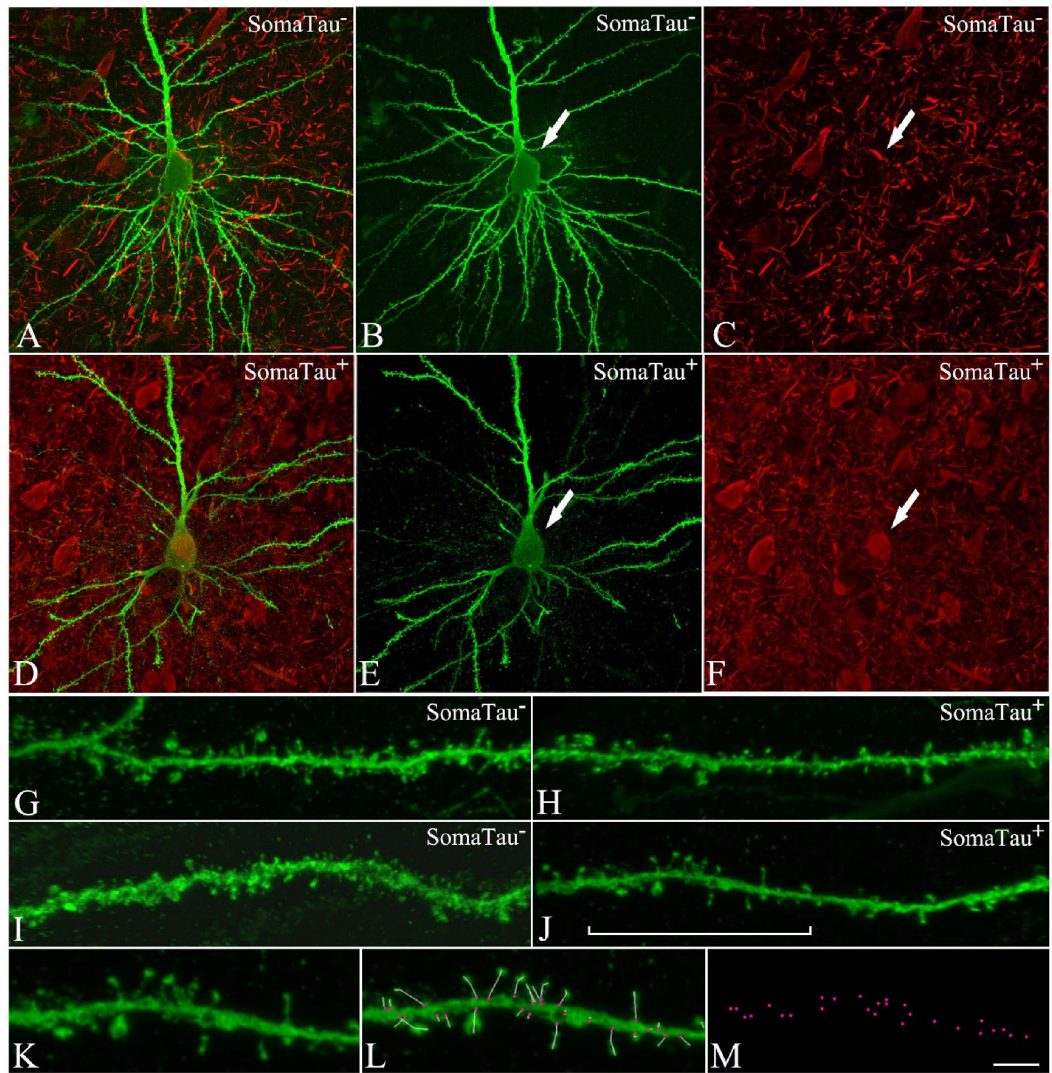
Figure 1. CA1 pyramidal neurons with and without tau pathology. Confocal microscopy pictures obtained after combining the channels acquired separately for LY (green) and phospho-tau AT8 (red), showing ( A–F ) neurons and ( G–J ) their basal dendrites, ( A–C,G–H ) with a soma free of phospho-tau AT8 (SomaTau-) and ( D–F,I–J ) with phospho-tau AT8 in an intermediate stage of neurofibrillary pathology (SomaTau +). The position of the soma is indicated with an arrow in ( B , C ) and ( E , F ). ( K ) High resolution image of a dendritic segment indicated with a bracket in J. ( L ) The same representative image as in ( K ) showing all the spines along the dendrite marked with a white line and pink dots for their insertion points. ( M ) 3D spatial distribution of all spines insertion points. Scale bar shown in ( M ) indicates 12 µm in ( A – F ), 5 µm in ( G–J ), and 3 µm in ( K – M analyses. In the first analysis, we assessed whether this organization can be explained by the loss of spines asso- ciated with tau pathology, a phenomenon that we have already reported in AD 13 . This analysis showed that the SomaTau + dendrites have a lower number of spines compared to their SomaTau- counterparts, although these differences did not reach statistical significance (SomaTau + = 323.0 ± 66.6, SomaTau- = 453.2 ± 135.2, p = 0.11). In the second analysis, we assessed whether SomaTau + dendrites have a different number of groups of spines that are closely connected with each other, which we refer to as mean grouping coefficient. This analysis showed that the mean grouping coefficient (GC) in SomaTau + dendrites was significantly higher ( GC SomaTau+ = 0.014 ± 0.003 μm −1 , GC SomaTau- = 0.011 ± 0.002 μm −1 , p < 0.001 (Fig. 4A,B), indicating that their spines were organized in more isolated groups along the dendrite, whereas the SomaTau- dendrites have spines that are more evenly spread along the dendrite. Replication in two independent AD cases. To assess the generality of these results, we repeated the analyses in two independent AD cases, whose samples were obtained using the same procedures described in the Methods. The first case (P9; gender: male; age: 82 years; cause of death: bronchopneumonia plus heart failure)